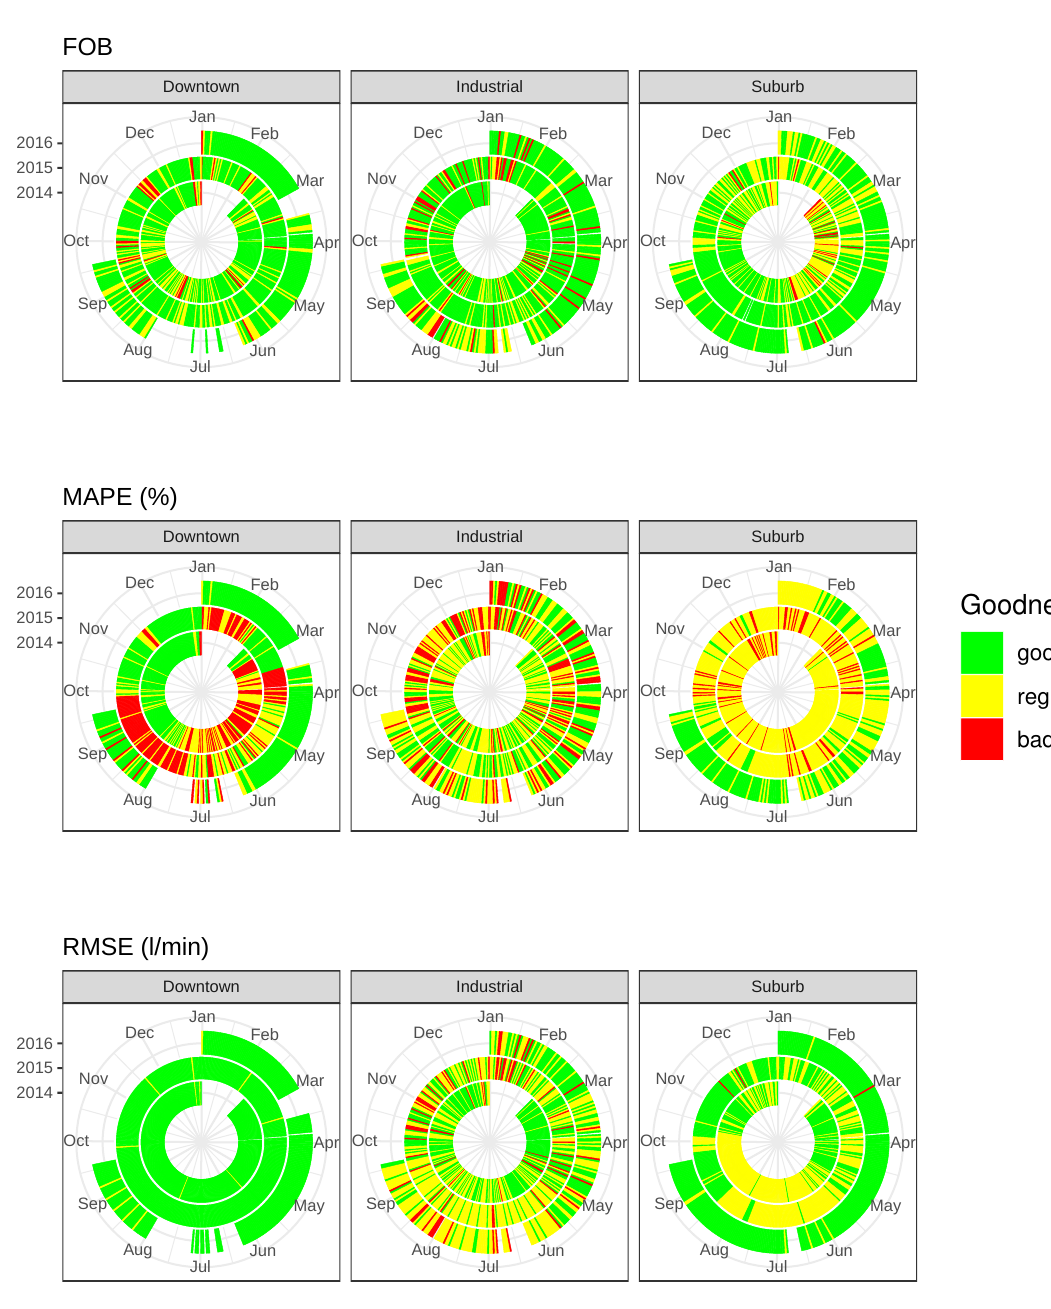
Figure 5. Daily values of the FOB (top plot), MAPE, and RMSE (middle plot) at the three sites from 2014 (inner circles) to 2016 (outer circles). The values are gathered into three different categories: good (green shading), regular (yellow shading), and bad (red shading), depending on the values taken by the GoF measure. For FOB, the categories are respectively defined by the intervals [ 0,0.2 ) , [ 0.2,0.5 ) , and [ 0.5, + ∞ ) ; for MAPE, the categories are defined by [ 0,20% ) , [ 20,50% ) , and [ 50%, + ∞ ) ; and for RMSE, the intervals defining the categories are (units in L/min) [ 0,5 ) , [ 5,15 ) , and [ 15, + ∞ )